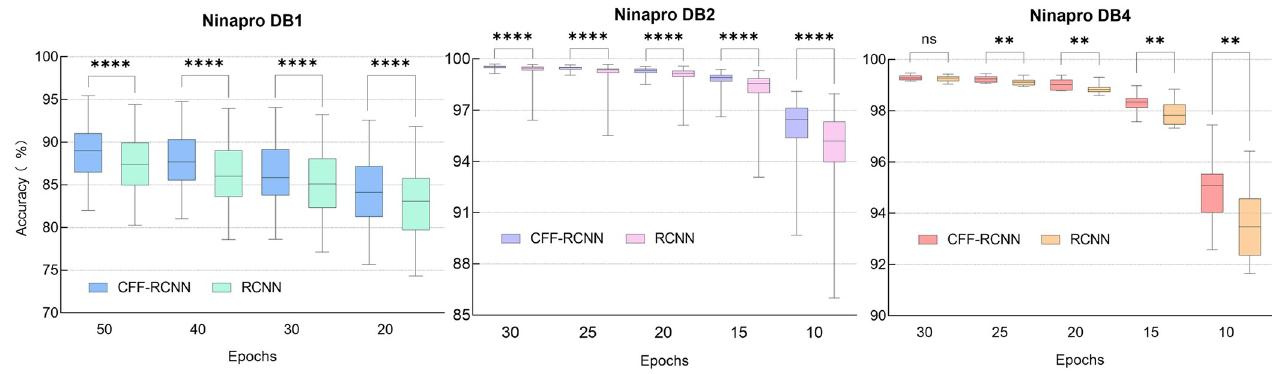
Fig 8. Comparisons between CFF-RCNN and RCNN on DB1, DB2 and DB4. P value style: 0.1234(ns), 0.0332( � ), 0.0021( �� ),0.0002( ��� ), < 0.0001( ���� ).